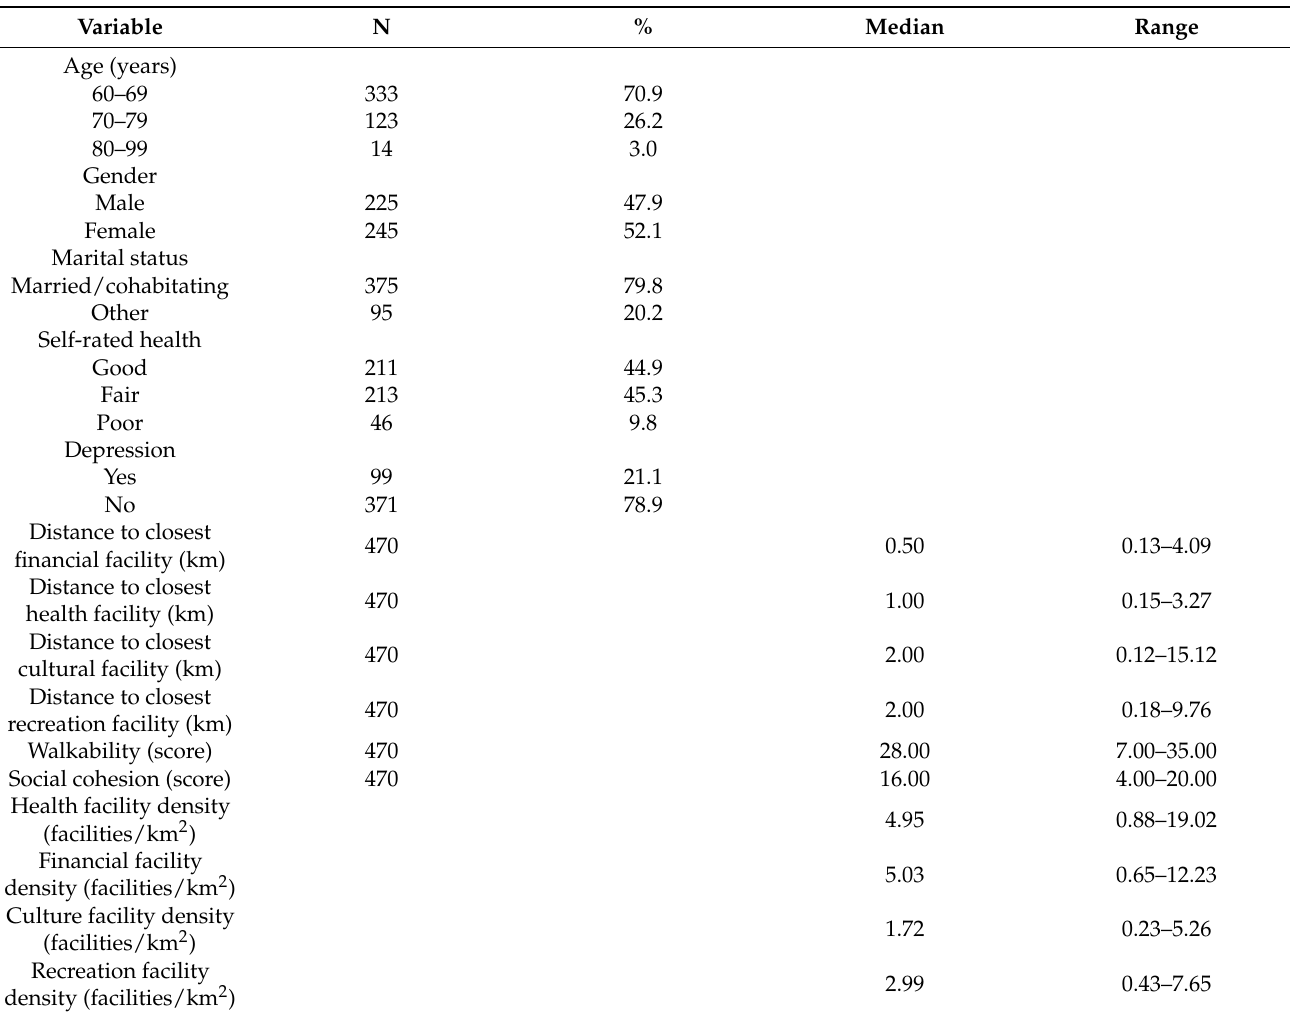
Table 1. Summary of participants’ characteristics and residential environment of individual-level and